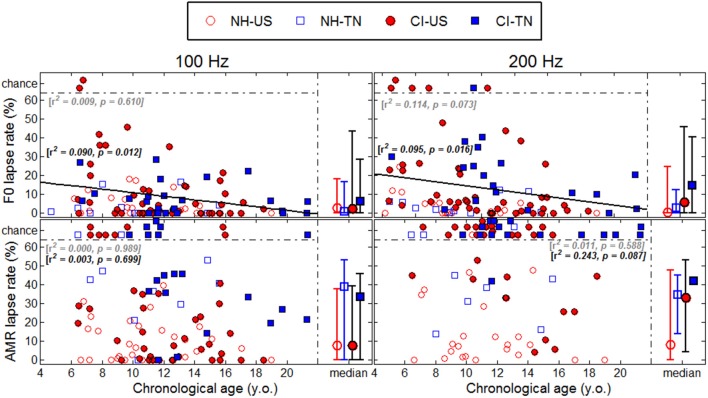
Same as Figure 2 for lapse rates.